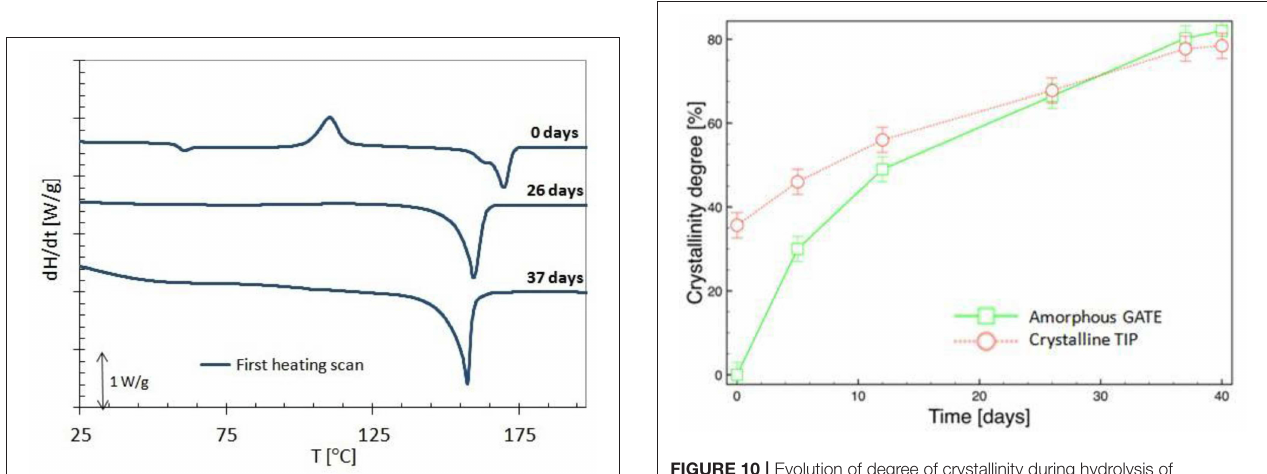
FIGURE 10 | Evolution of degree of crystallinity during hydrolysis of micro-injected biphasic PLA sample (amorphous gate, crystalline tip).